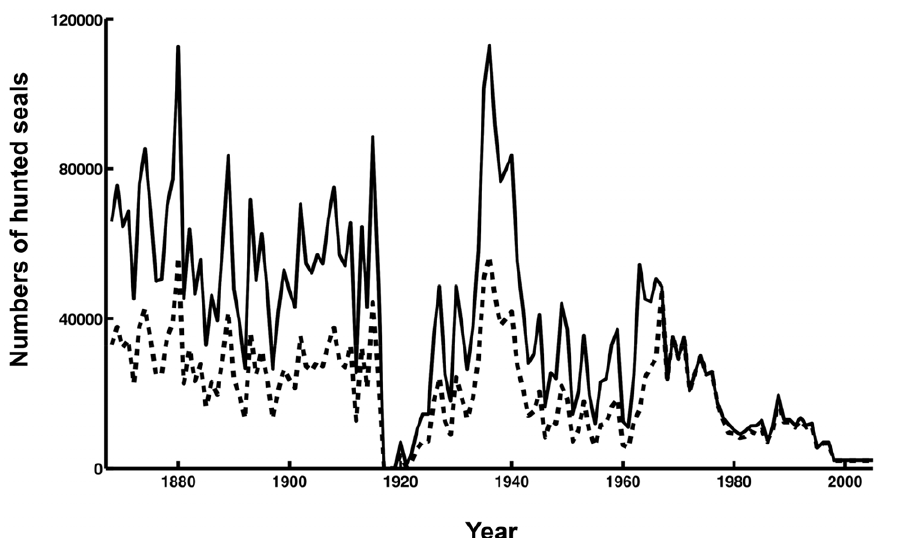
Figure 1. Total registered harvest of Caspian seals (solid line) and the number of pups (dashed line) for the period 1867–2005. Based on published hunting records [14,15,16]. Data for recent years are derived from Russian Federal Fisheries Agency reports [29,30].